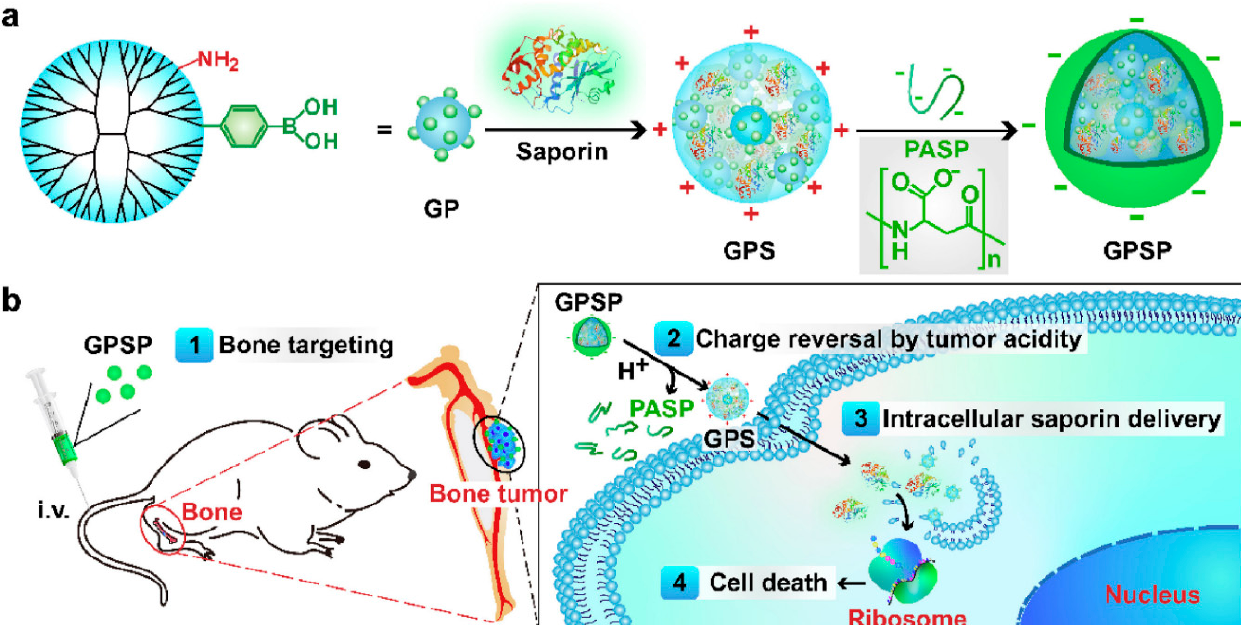
Figure 9. ( a ) Design of bone-targeted, protein-functionalized, dendrimer-based nanomedicine for treating malignant bone tumors. ( b ) Schematic representation of the mode of action of the developed nanosystem. Reprinted from an open-access source [113]. Abbreviations: